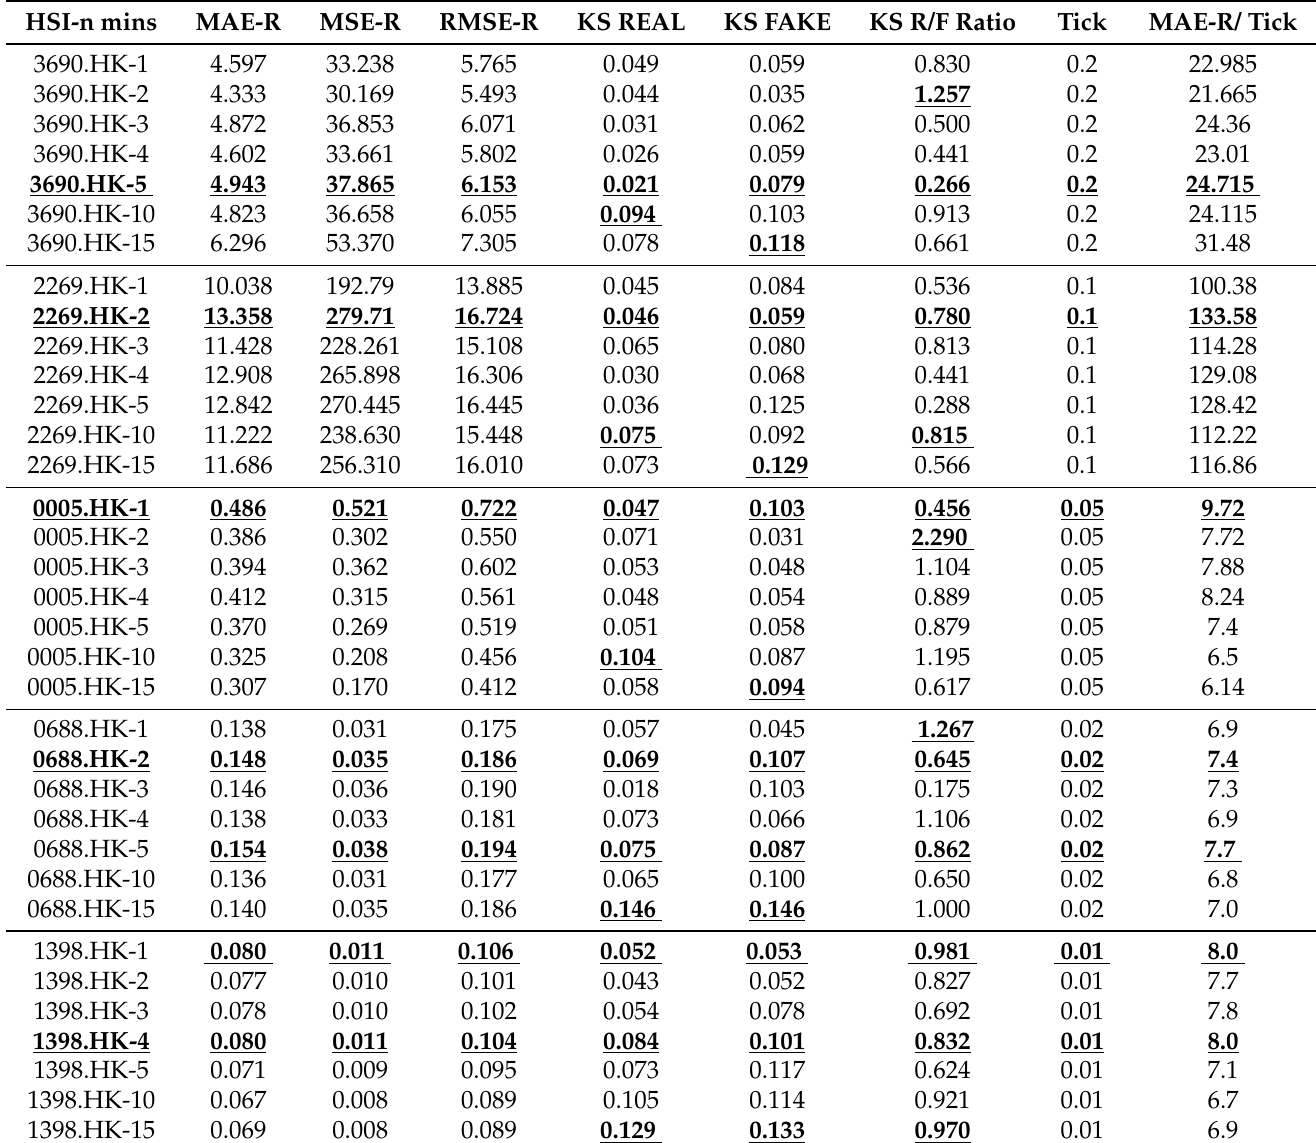
Table 4. We selected several typical stocks at different tick values and reported the performance of our model at one, two, three, four, five, ten and fifteen minute intervals. Tick values include 0.2, 0.1, 0.02, 0.05 and 0.01. 2269.HK-15 min in Table 4 shows highest MAE-R/ Tick in all minute intervals compared with other selected representatives by